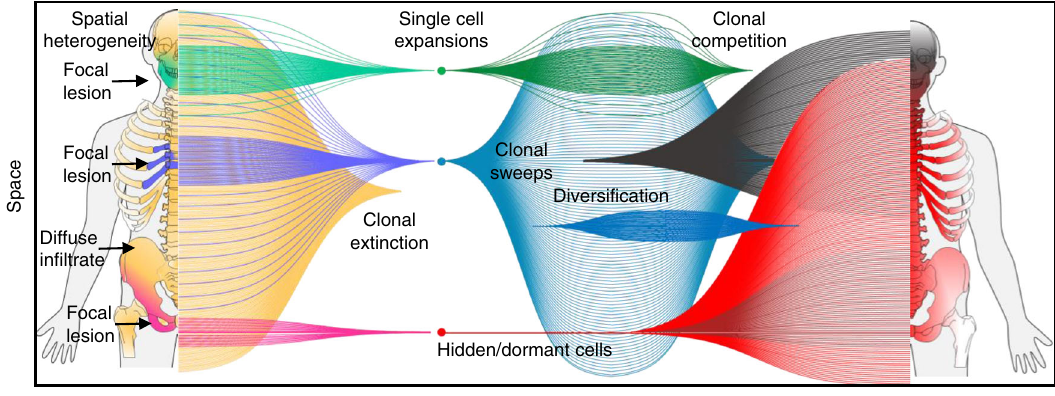
Fig. 8 | Summary of the spatial-temporal evolution of multiple myeloma. The fi gure summarizes our fi ndings and the complexity of myeloma evolution seen in this study. It includes spatial heterogeneity at baseline and after treatment, a link between subclones and growth patterns, resistant clones that may be hidden/